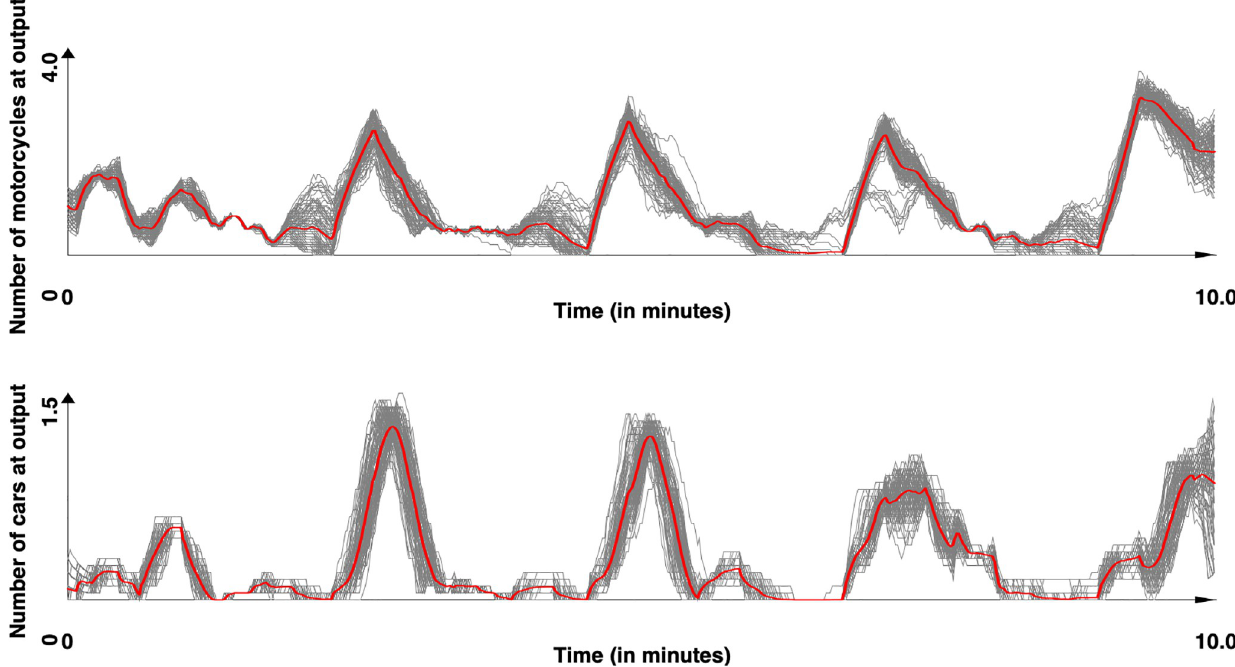
Fig 11. Simulated results for the Chua Boc site. Motorcycle and car counts for the 100 simulations with [44] model (time series were smoothed out using moving average with a window size of 10s). In red, the mean values.